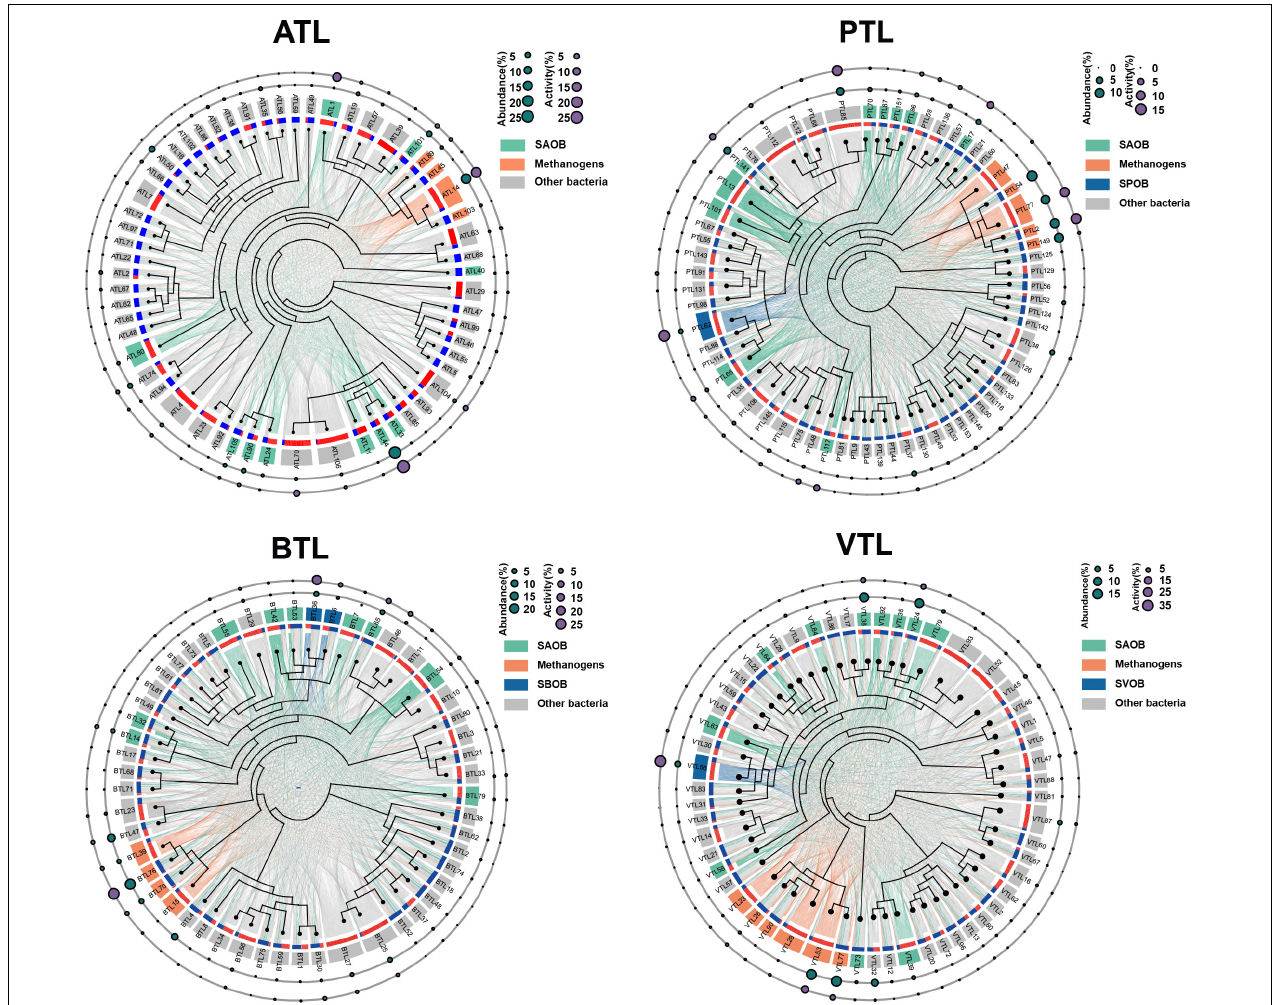
FIGURE 2 | Potential complementarity in amino acid (AA) synthesis among the community members in each chemostat. The ATL, PTL, BTL, and VTL represent the thermophilic methanogenic chemostats supplemented with acetate, propionate, butyrate, and isovalerate as sole carbon source, respectively. The internal tree diagram depicts the phylogenetic relationship among the community members. The outer colored donuts indicate different functional groups, as shown in the left of each figure. All the members are connected by the lines reflecting their functional complementarity. Each link starts from an metagenome assembled genomes (MAG) that “contributes” AAs (labeled with the red patch) and ends with an MAG that “obtains” the AAs (labeled with the blue patch). The strength of the relationship is characterized by the thickness of the line. An additional diagram is given in Supplementary Figure 5 . Accordingly, the width of red patch for a given MAG indicates its potential to “contribute” AAs to the community, whereas the width of blue patch for a given MAG indicates its potential to “cheat” AAs from the community. Dark green and purple bubbles in the outside concentric rings indicate the abundance and overall activity of community members,